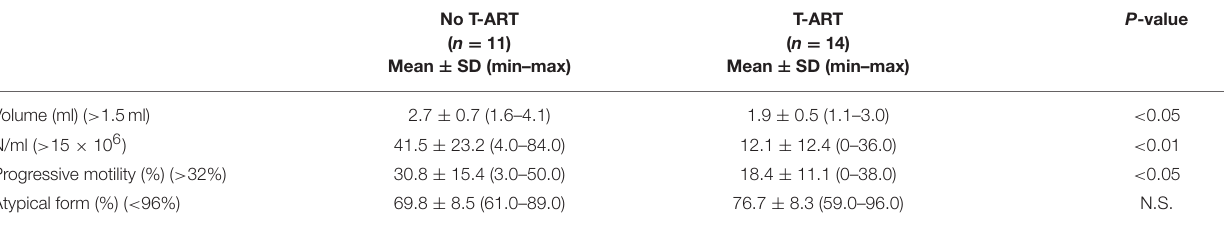
TABLE 2 | Semen parameters in patients without and with testicular adrenal rest